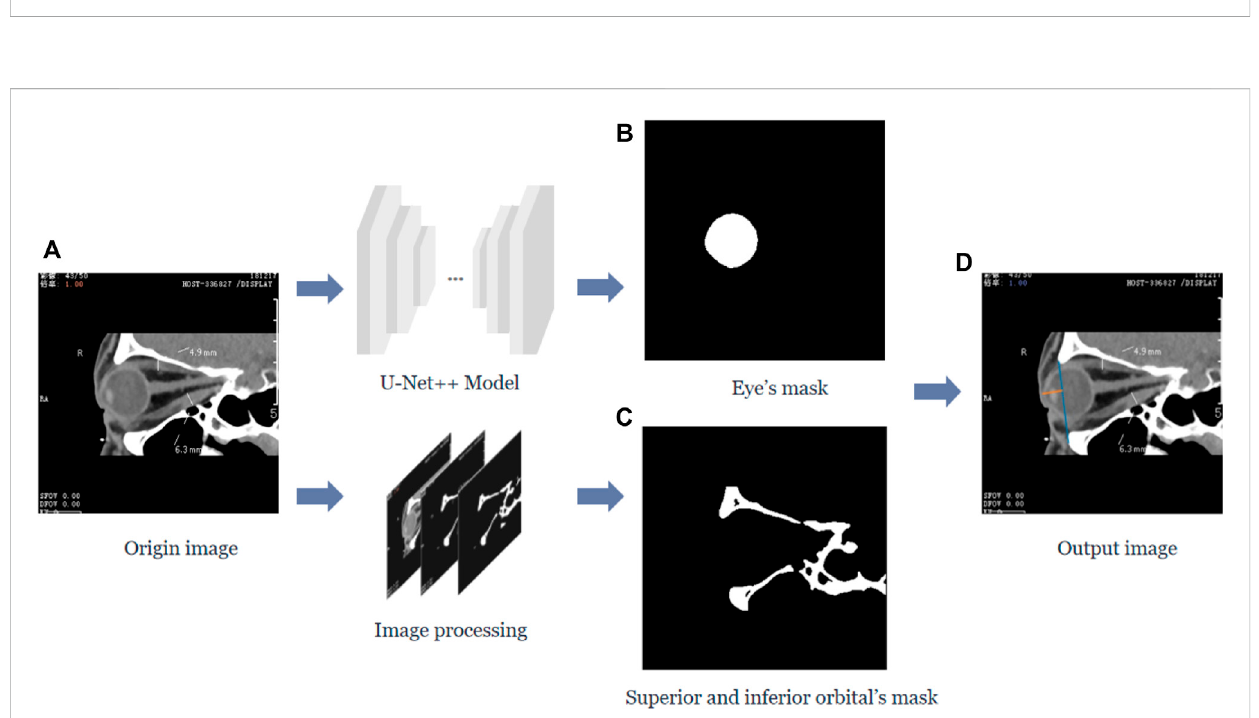
FIGURE 2 The vertical distance from the apex of the anterior surface of the cornea to the longest line between the superior and inferior orbital margins in the sagittal plane of the CT image. (A) Represents the original sagittal CT image, and after the U-Net++ model and Image processing, we obtain the binary images of the eye region mask shown in (B) and the upper and lower orbital rim regions shown in (C) , and then after locating the coordinates of the anterior surface apex of the eye and the upper and lower orbital rims, we obtain the line from the apex of the upper and lower orbital rims representedbythebluelinein (D) andtheverticaldistanceofthelinefromtheapexoftheanteriorsurfaceofthecorneatotheupperandlowerorbitalrim most protruding points represented by the orange